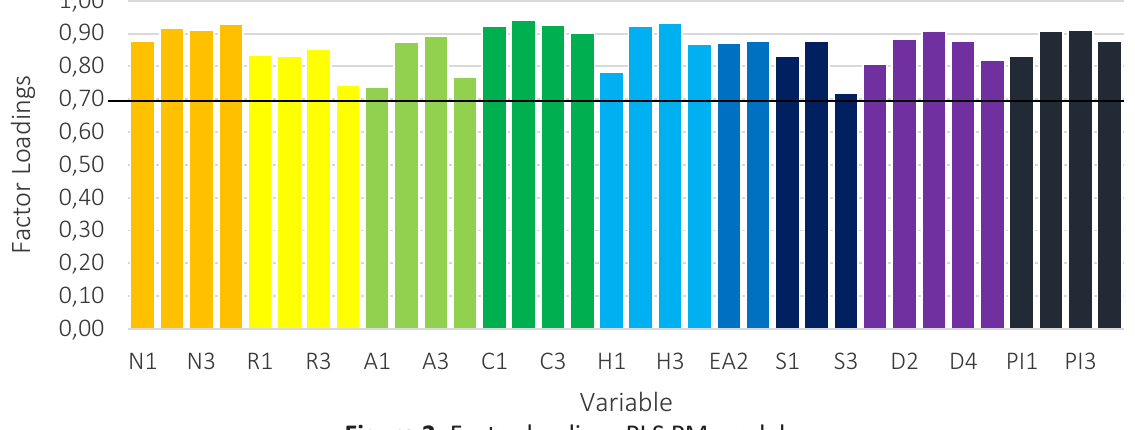
Figure 2. Factor loadings PLS PM